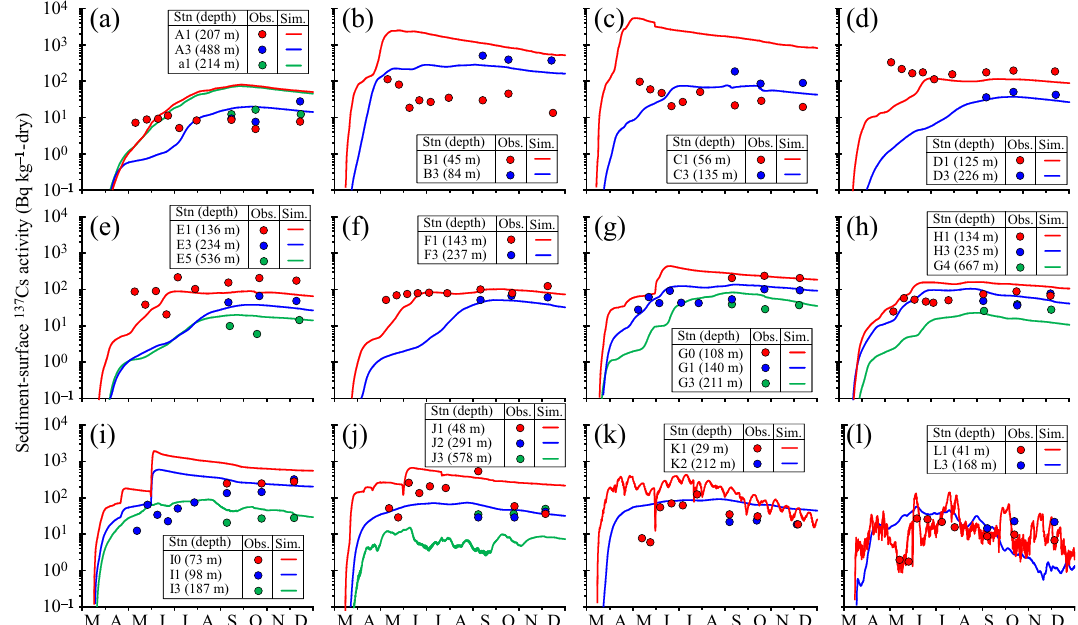
Figure 6. Time series of observed (circular plots) and simulated (lines) sediment-surface 137 Cs at MEXT (2011) stations. Locations of observations are shown in Fig. 1b. Water depths are according to Kusakabe et al. (2013).